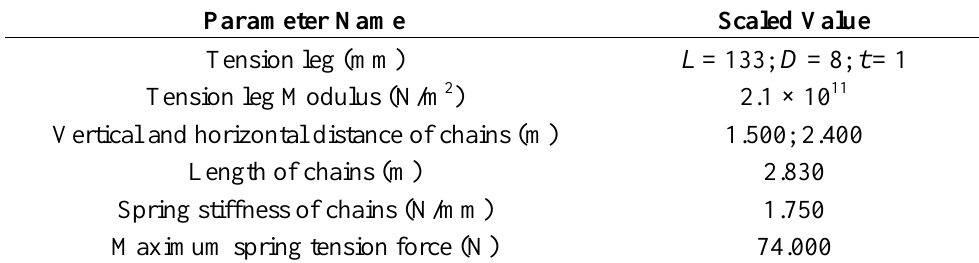
Table 3. The main design parameters of the mooring system.